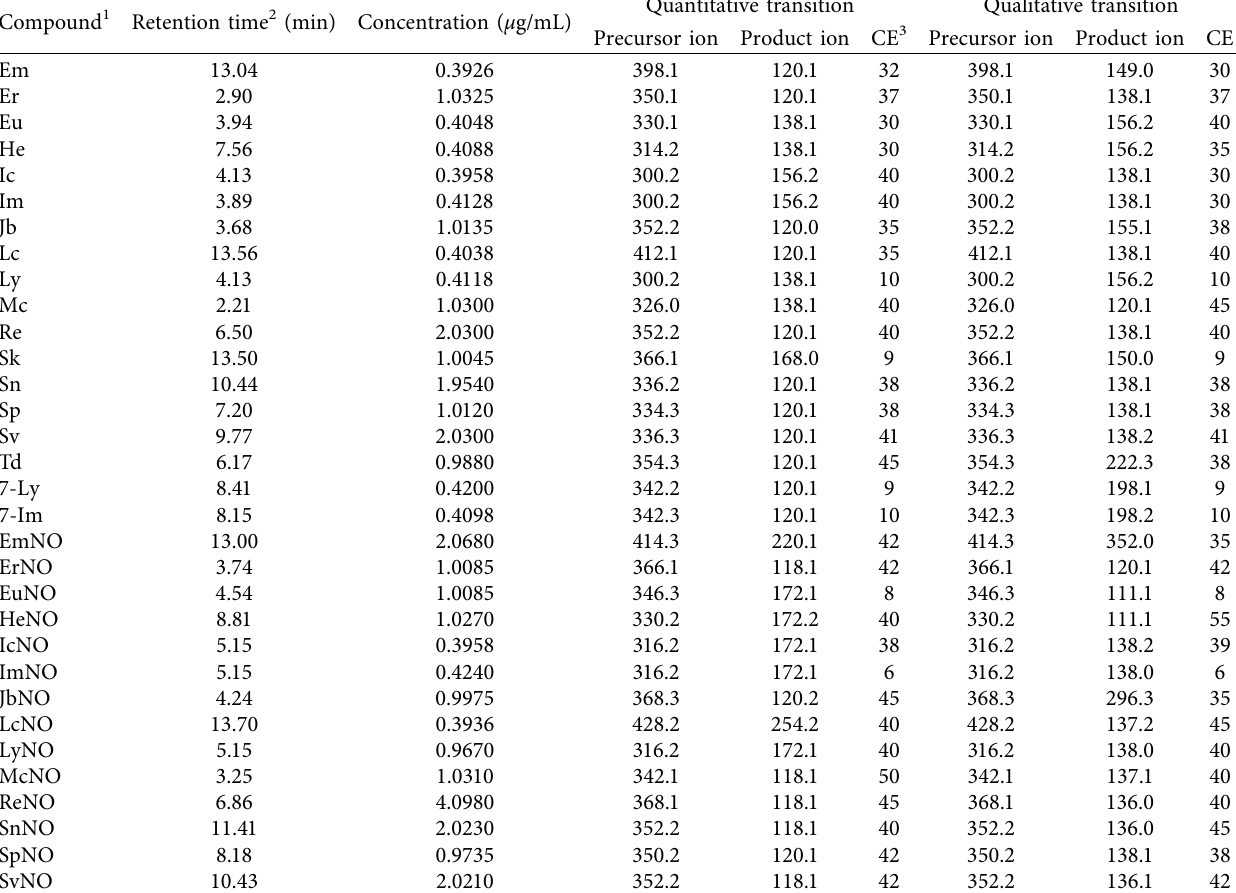
Table 1: Retention time, concentration, and mass spectrometry conditions for 32